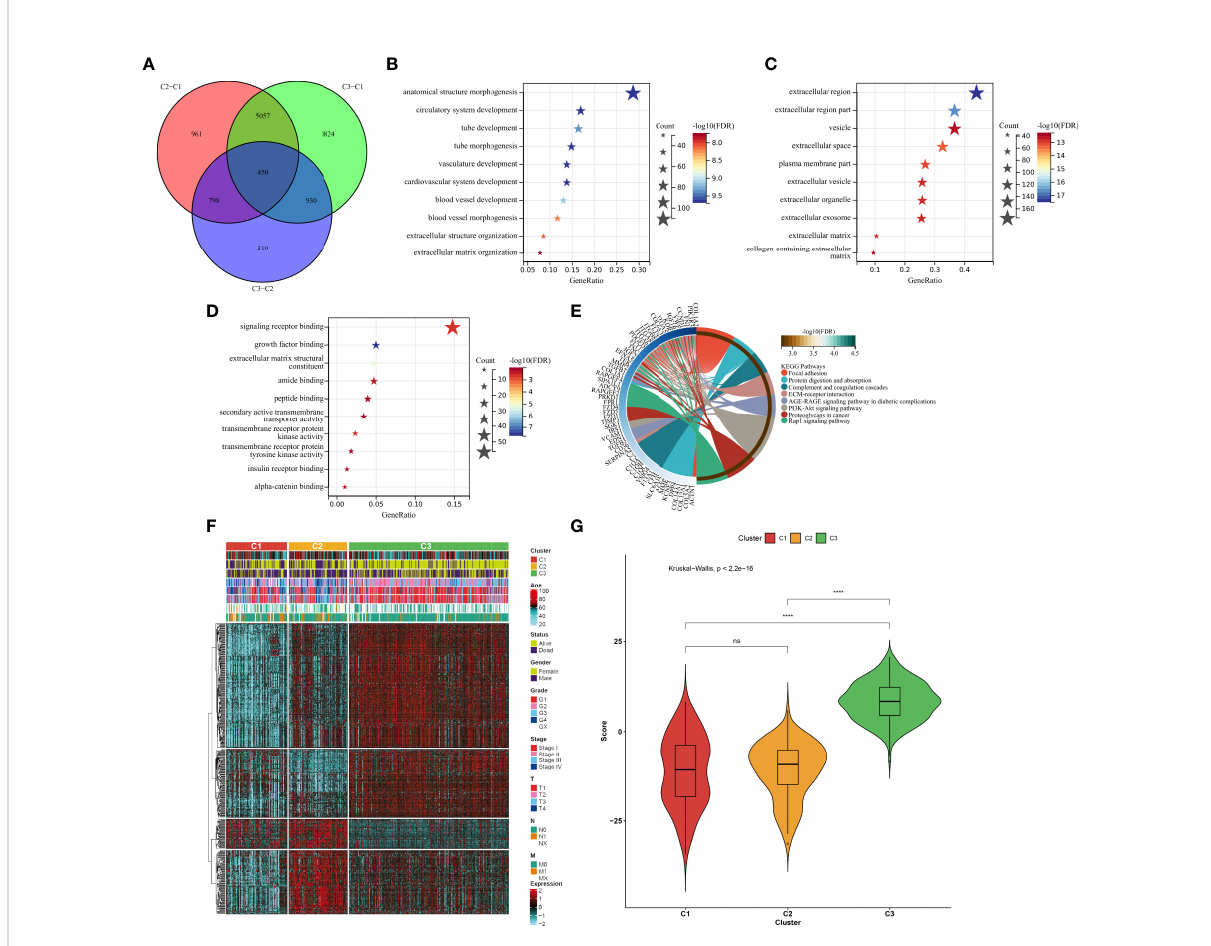
FIGURE 5 Identi fi cation of the aging phenotype-associated genes and generation of an agingScore system for ccRCC. (A) Venn diagram for the aging phenotype-associated genes via comparing the aging phenotypes. (B – D) The major (B) biological processes, (C) cellular components, or (D) molecular components enriched by aging phenotype-associated genes. (E) The major KEGG pathways enriched by aging phenotype-associated genes. (F) Distribution of the expression patterns of the aging phenotype-associated genes and clinical features across the three aging phenotypes. (G) Box plots of the distribution of agingScore among the three aging phenotypes. Ns, no signi fi cance; **** P <